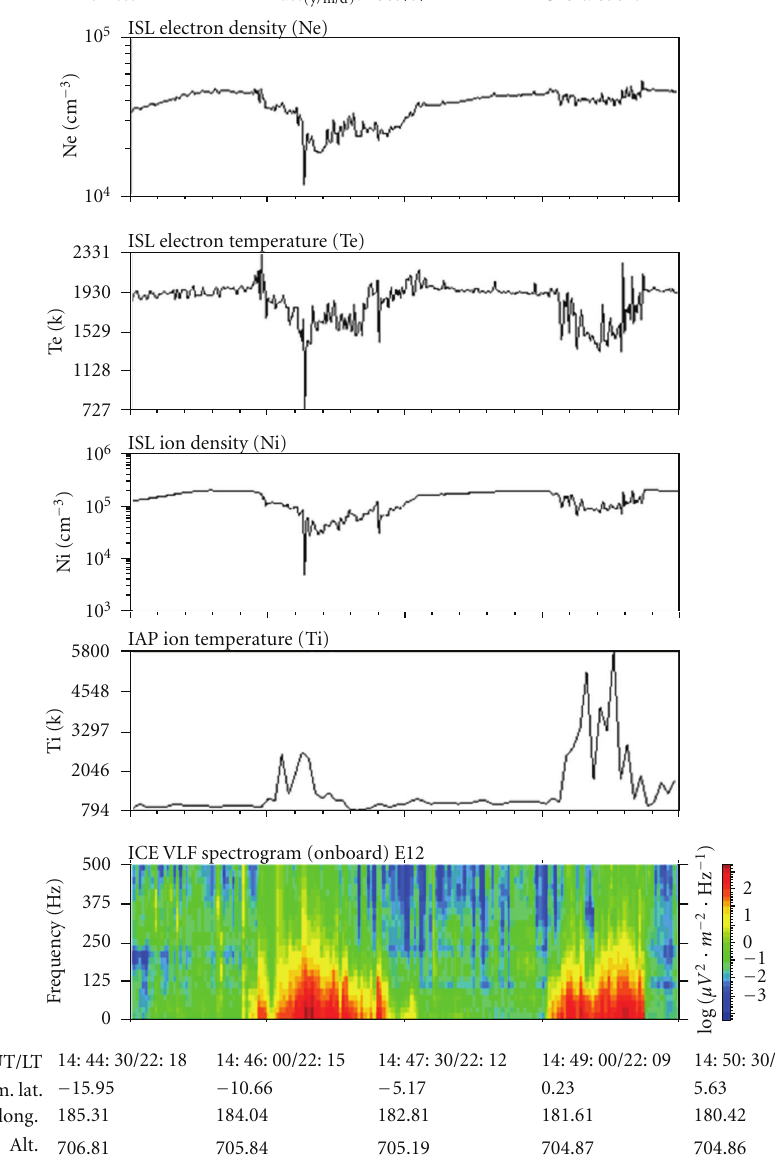
Figure 12: Quick look complex diagram of the DEMETER satellite data of the nigh-time pass over the area of preparation of the Sumatra 28 March 2005 M8.7 earthquake obtained on 22 March. From top to bottom: electron concentration, electron temperature, ion concentration, ion density, and dynamic spectrogram of electric component within the frequency band 0–500